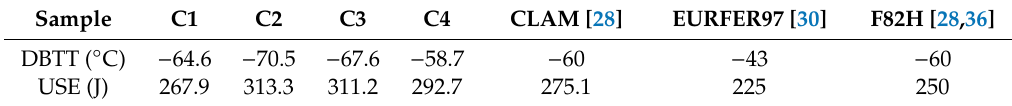
Figure 11. The variation in impact energy of the RAFM steels with test temperature. Table 3. Upper shelf energies (USEs) and ductile-to-brittle-transition temperatures (DBTTs) obtained from the Charpy impact tests.